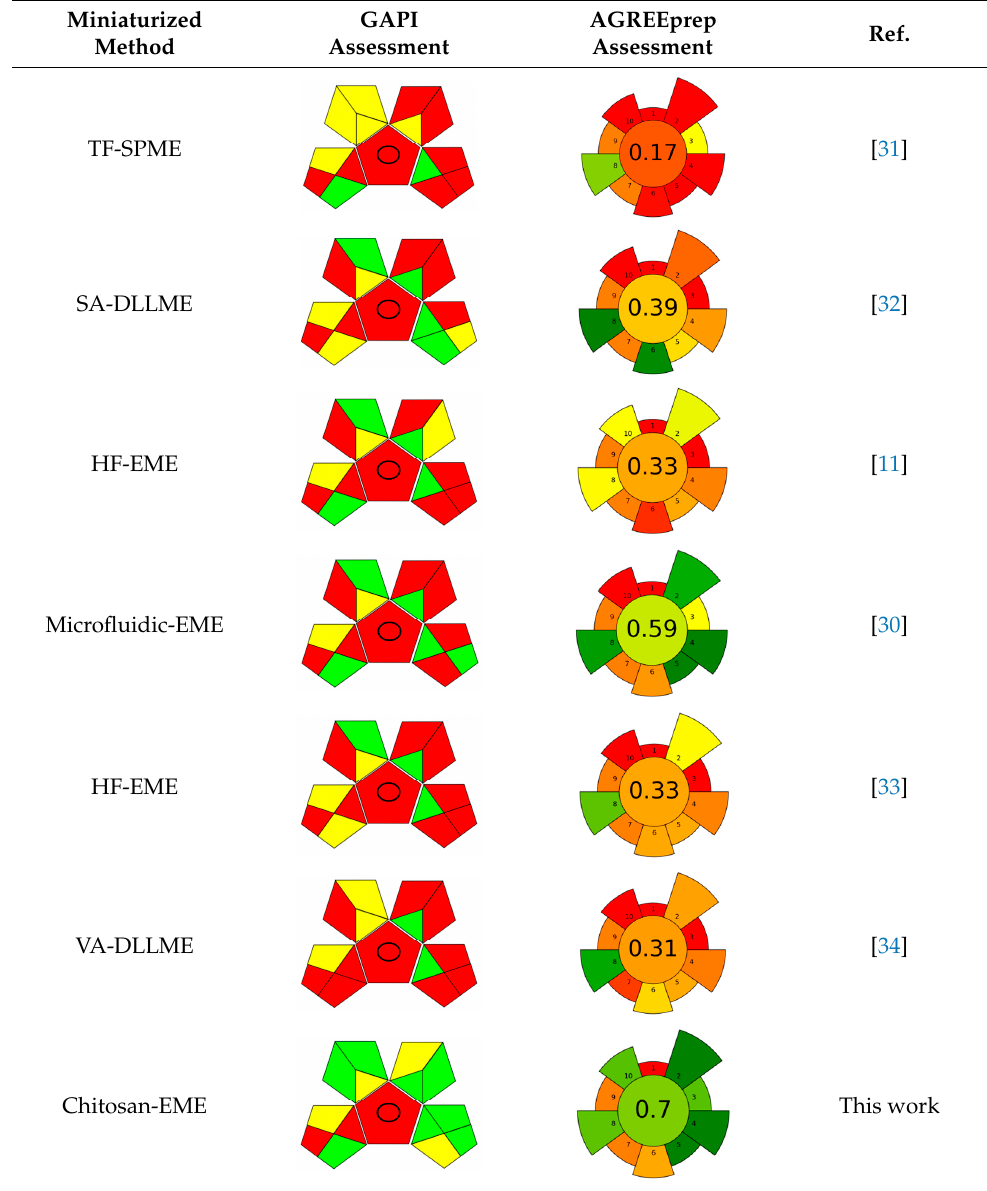
Table 4. Greenness assessment of the proposed chitosan-based procedure and the other systems compared.